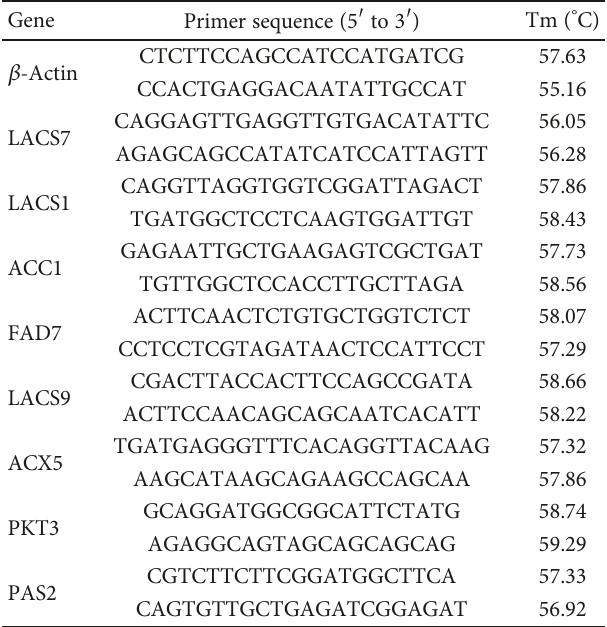
Table 1: qRT-PCR validation